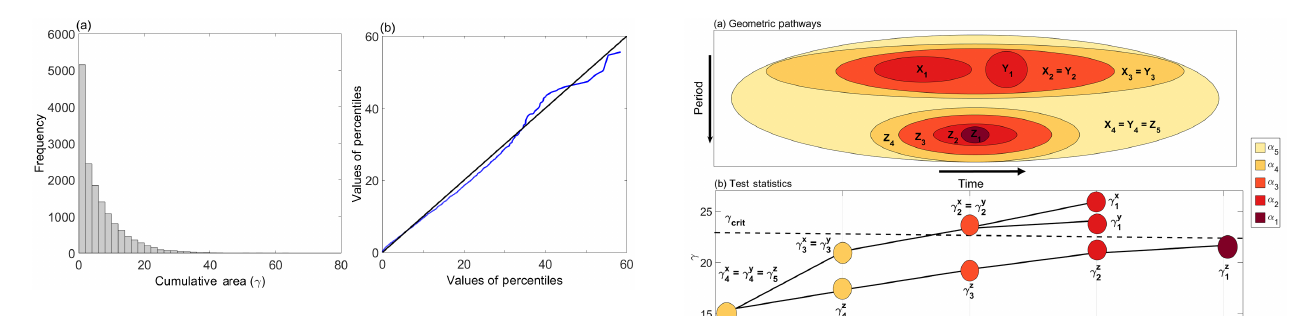
Figure 8. (a) Null distribution of γ obtained by generating 10000 geometric pathways under the null hypothesis of red-noise, where the red-noise processes were of length 1000 and had lag-1 auto- correlation coefficients equal to 0.5. (b) Percentiles of a theoretical exponential distribution with mean 6.5 plotted as a function of the percentiles calculated from the distribution shown in (a) .